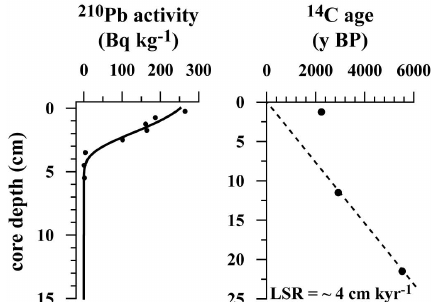
Fig. 2. Left: 210 Pb profile for station 4, after correction for sup- ported 210 Pb (66Bqkg − 1 ) and model fit (see text for details on fit- ting). Points are experimental data, solid line is model fit. Right: 14 C ages for top, middle and bottom sample from station 4. The linear sedimentation rate (LSR) of ∼ 4cmkyr − 1 was calculated based on the age difference between the middle and bottom sample (dashed